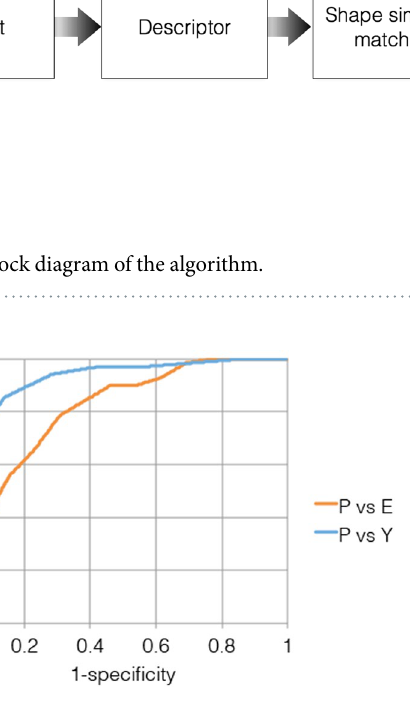
Figure 2. Algorithm discrimination performance. ROC curves of Young vs. PD and Elderly vs.